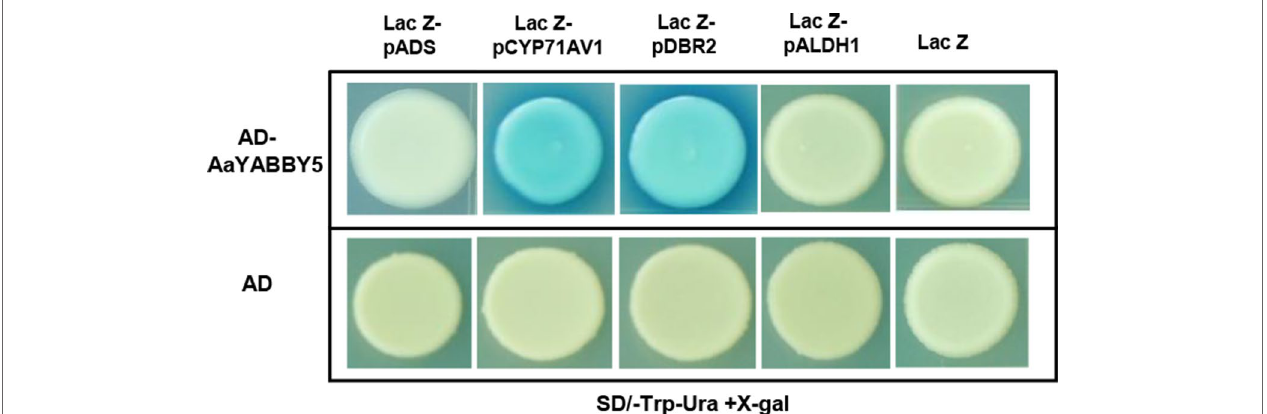
FIGURE 5 | Yeast one hybrid (Y1H) assay. Y1H assay was performed using the open reading frame (ORF) sequence of AaYABBY5 as prey and promoters of ADS , CYP71AV1 , DBR2 , and ALDH1 as bait. The GenBank accession numbers of pADS , pCYP71AV1 , pDBR2 , and pALDH1 are DQ448294, FJ870128, KC118523.1, and KC118525.1, respectively. AaYABBY5 directly bound to full-length CYP71AV1 and DBR2 promoters in yeast cells transformed with pB42AD-AaYABBY5 and plac-Z- CYP71AV1 /plac-Z- DBR2 , as shown by the appearance of blue colonies, whereas no binding was observed in the case of ADS and ALDH1 promoters. Yeast cells transformed with empty pB42AD in combination with placZ- ADS /placZ- CYP71AV1 /placZ- DBR2 /plac-Z- ALDH1 and empty vectors pB42AD + placZ were used as negative